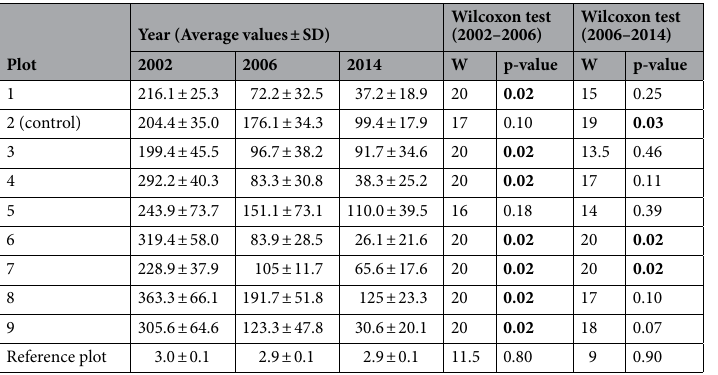
Table 2. Oil concentration in soil (mg g −1 ); 0–20 cm depth (9 collected samples per plot). SD denotes standard deviation; significant differences (p < 0.05) are